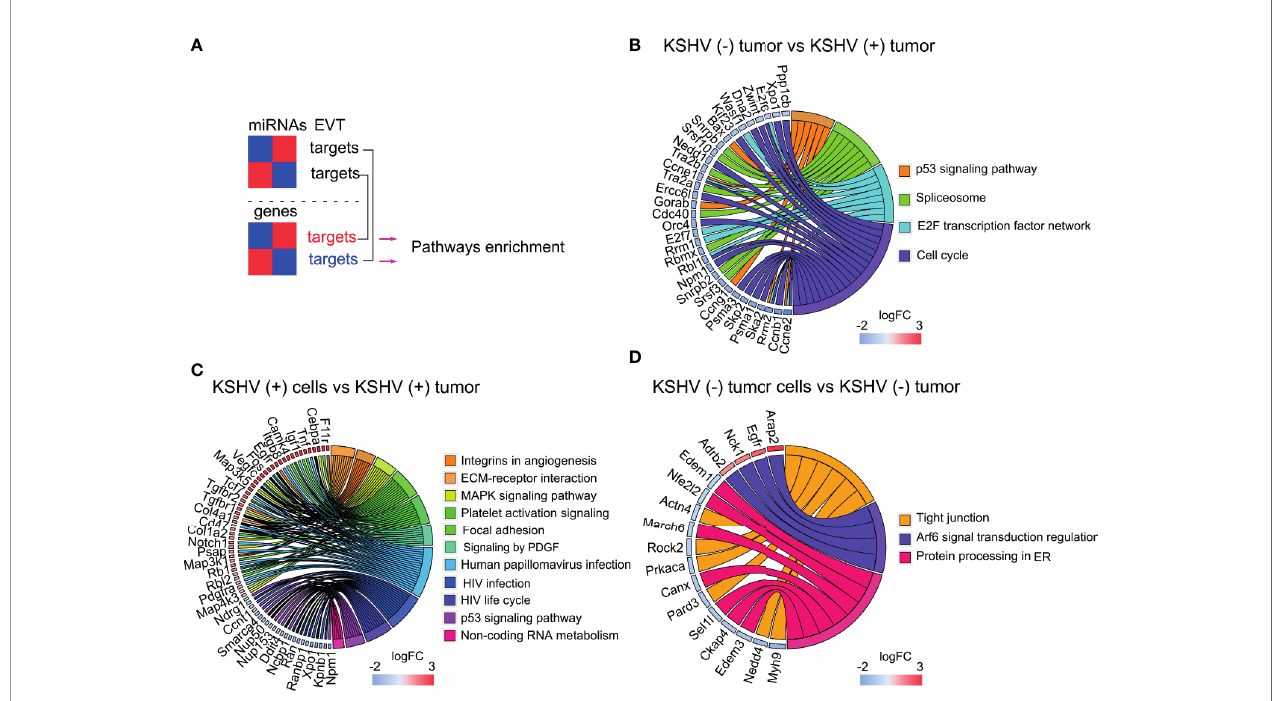
FIGURE 5 | Pathway analysis of DE miRNAs and their experimentally validated target (EVT) genes. (A) Schematic representation of the miRNA – mRNA pairs with signi fi cant (p < 0.05) antagonistic expression. (B – D) Chord plot illustrating the GO biological process terms and the target genes contributing to that enrichment arranged in order of their expression level in KSHV ( − ) tumors versus KSHV (+) tumors (B) , KSHV (+) cells versus KSHV (+) tumors; for a better visualization only a fraction of the genes corresponding to the plot is shown. The full list is available in Supplementary Table 5 (C) and KSHV ( − ) tumor cells versus KSHV ( − ) tumors (D)